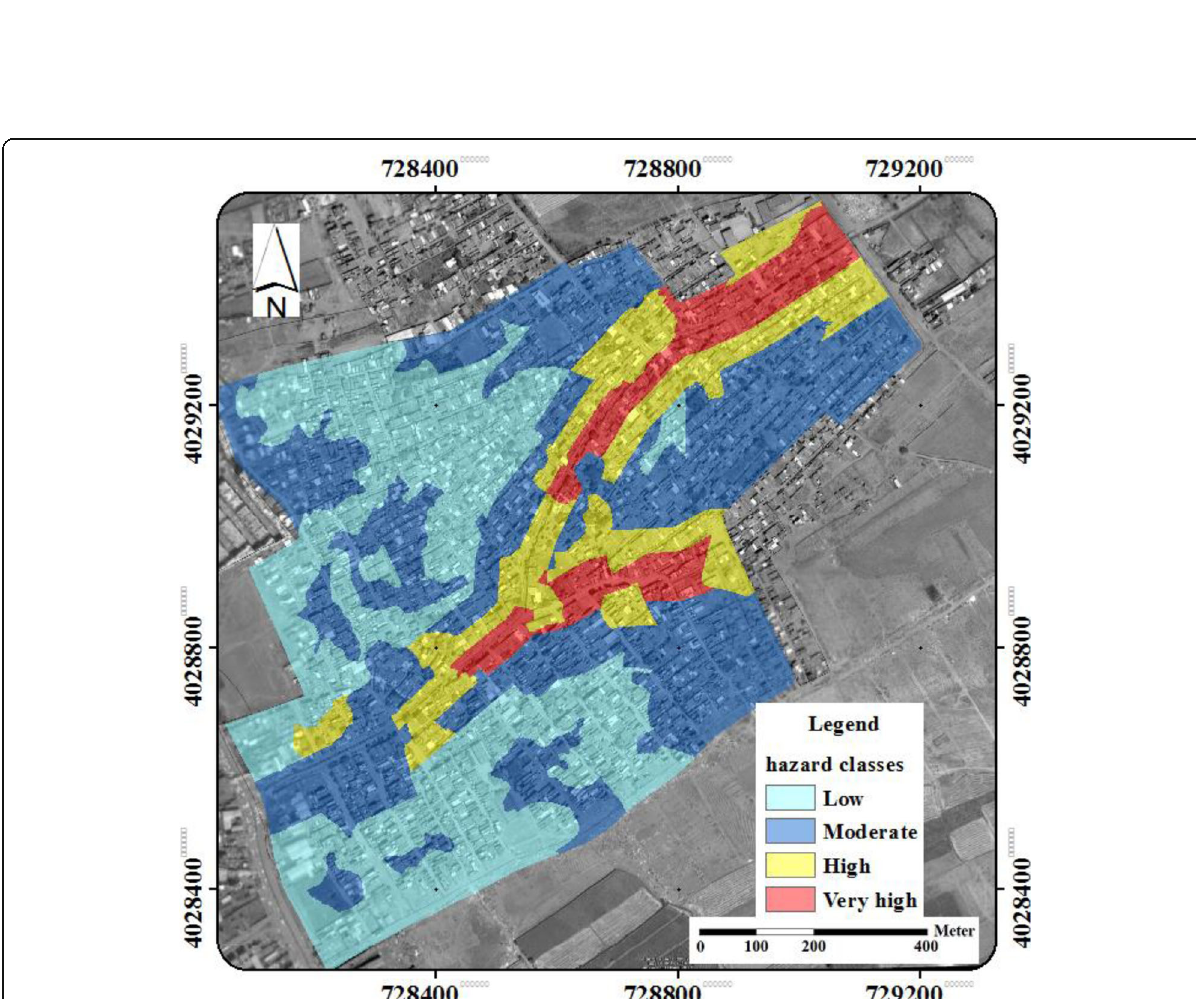
Fig. 11 Final inundation hazard map of the study